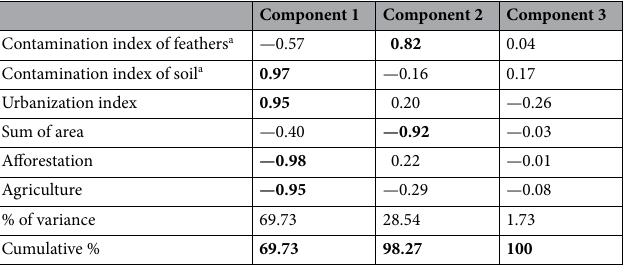
Table 4. Table of factor loadings matrix, loading ≥ 0.5 are shown in bold. a Contamination index of feathers and contamination index of soil represent the sum of all determined elements (As, Cd, Pb, Cr, Ni, Zn) for individual